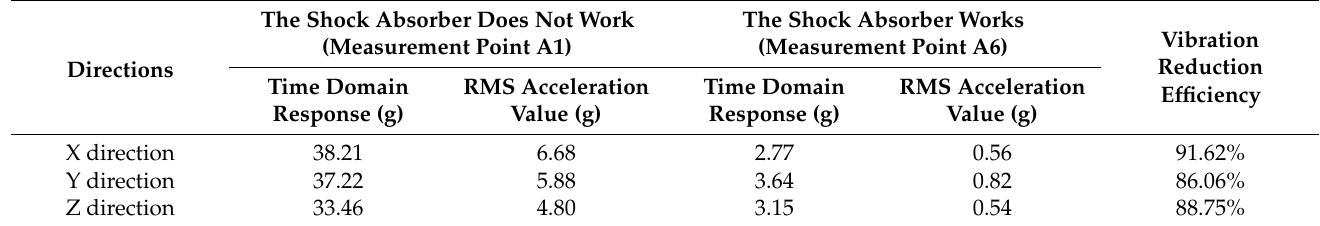
Table 6. Comparison of vibration damping performance